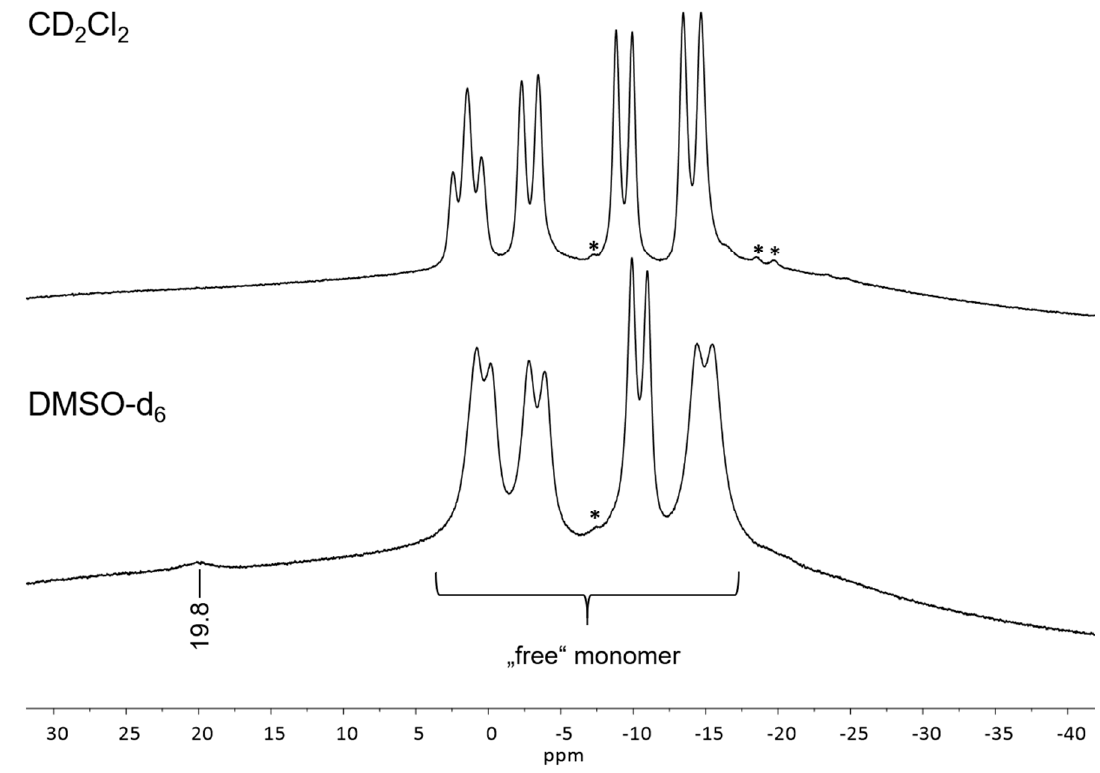
Figure 4. 11 B NMR spectra (at 128.83 MHz) of 3 freshly dissolved in CD 2 Cl 2 ( top ) and wet DMSO- d 6 ( bottom ). Signals for monomeric 3 and the signal for self-assemblies of 3 are observed in DMSO- d 6 , as suggested by Deore et al. and Crociani et al. [24,25]. * marks the low-intensity additional 11 B signals, probably due to solvent effects.